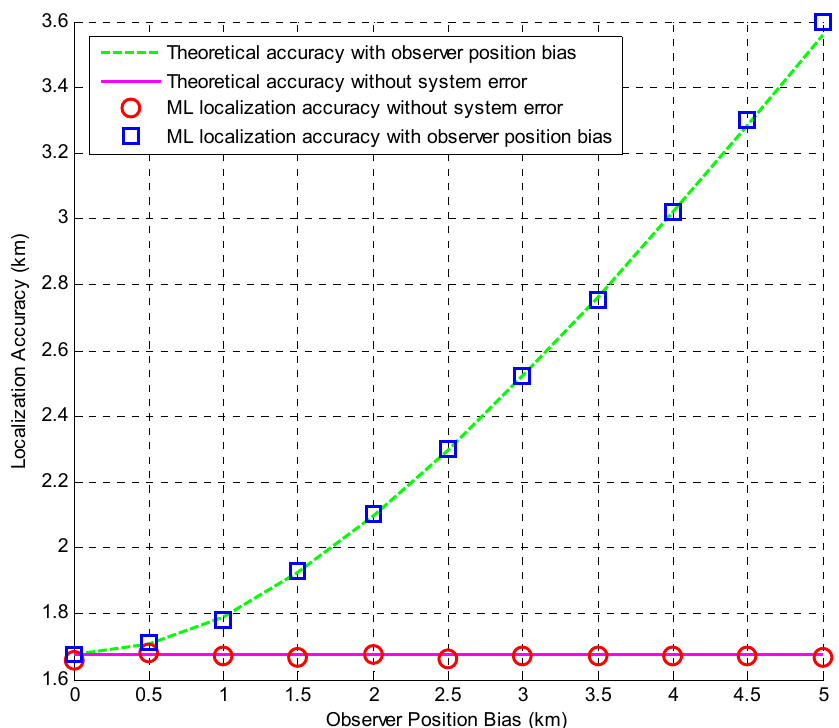
Figure 6. Localization accuracy comparison using the LEO and airplane by varying observer position bias.